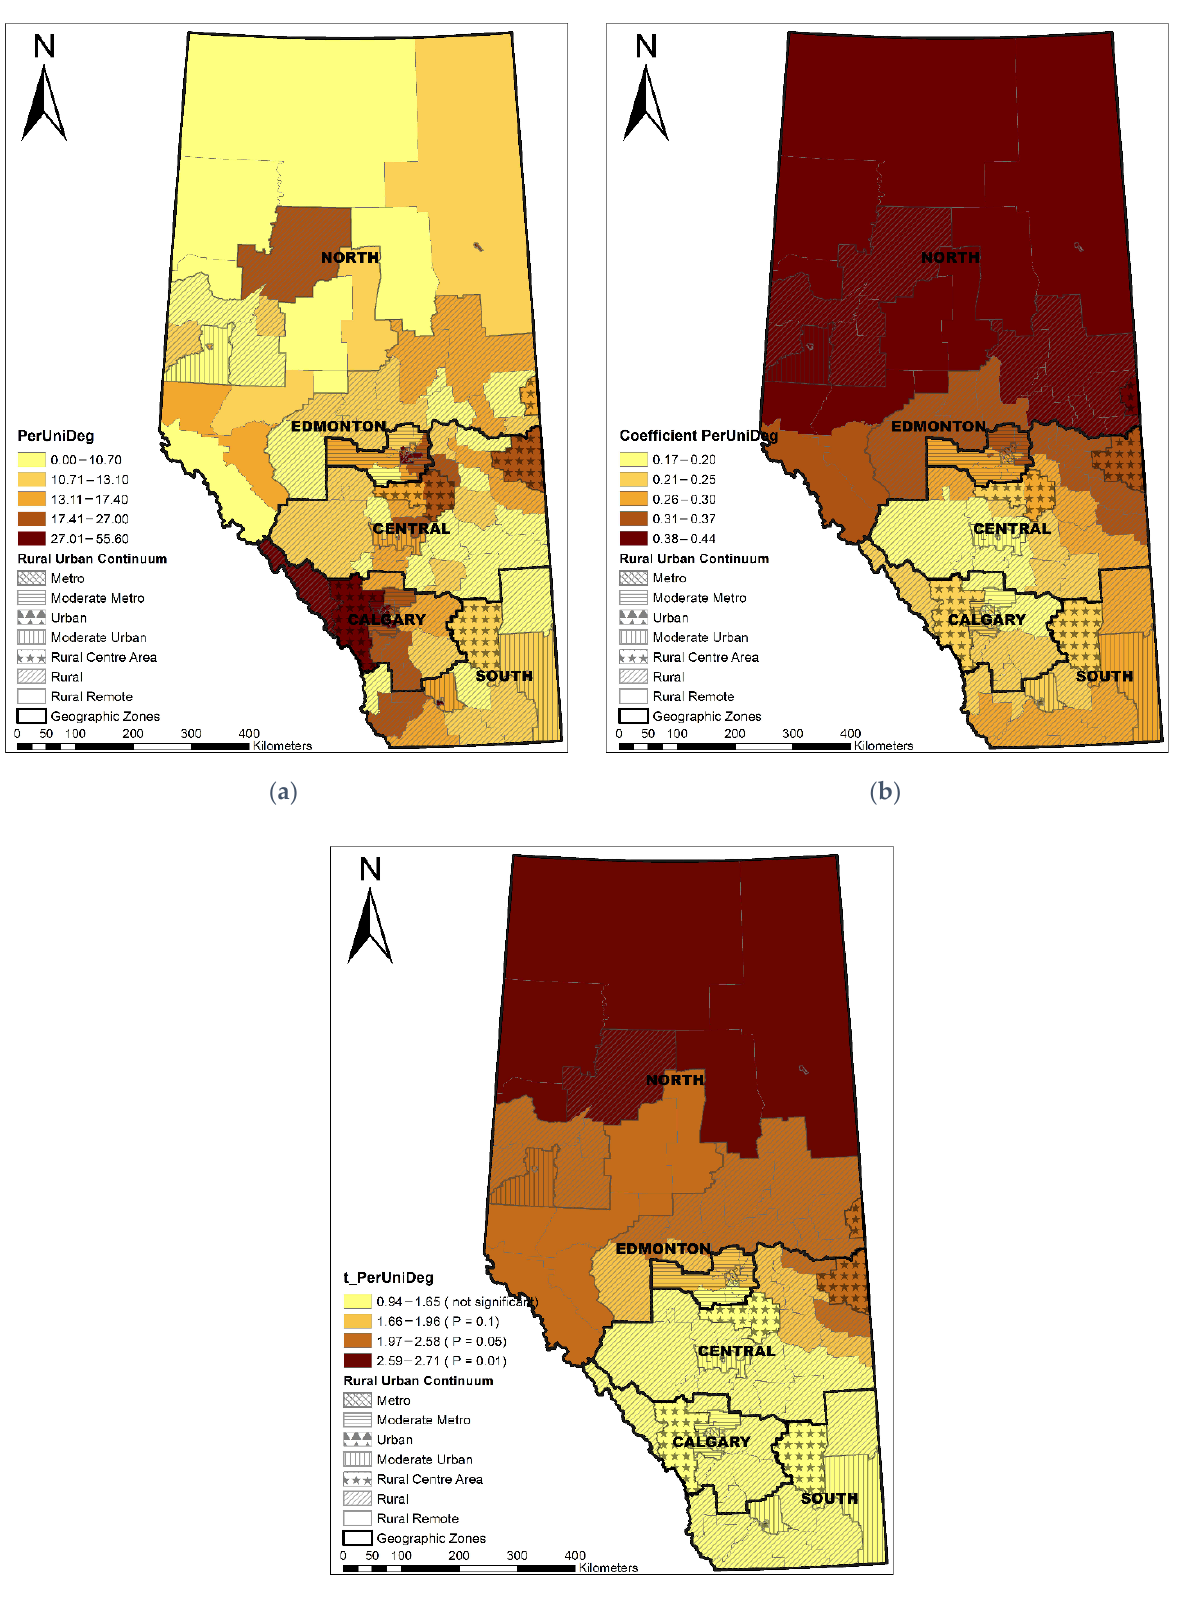
Figure 8. Distribution of percentage of people with university degrees ( a ), coefficient of percentage of university degrees ( b ), and significance of coefficient ( c ).